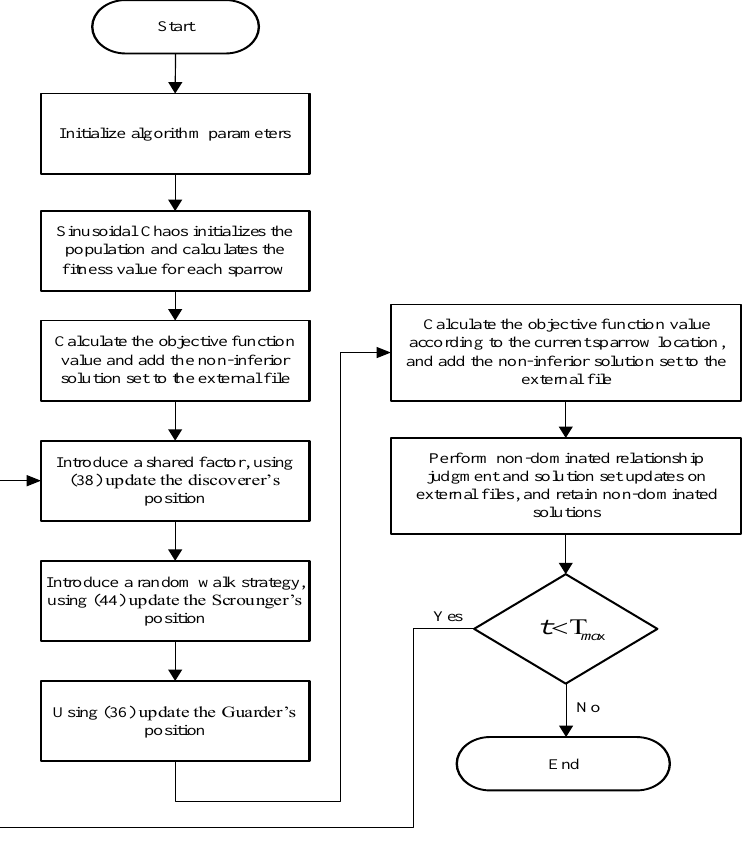
Figure 6. Flowchart of multi-objective